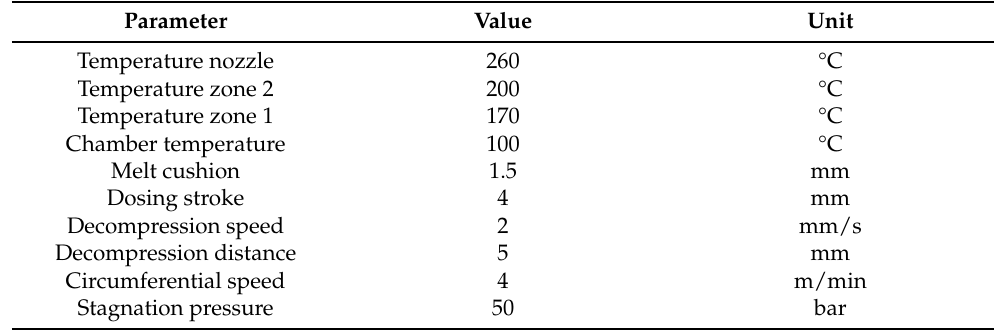
Table 3. Overview of the machine parameters used for the freeformer. All parameters were kept constant for the manufacturing of the specimens.